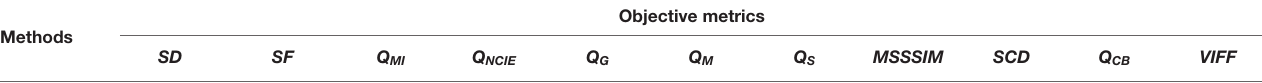
Objective metrics